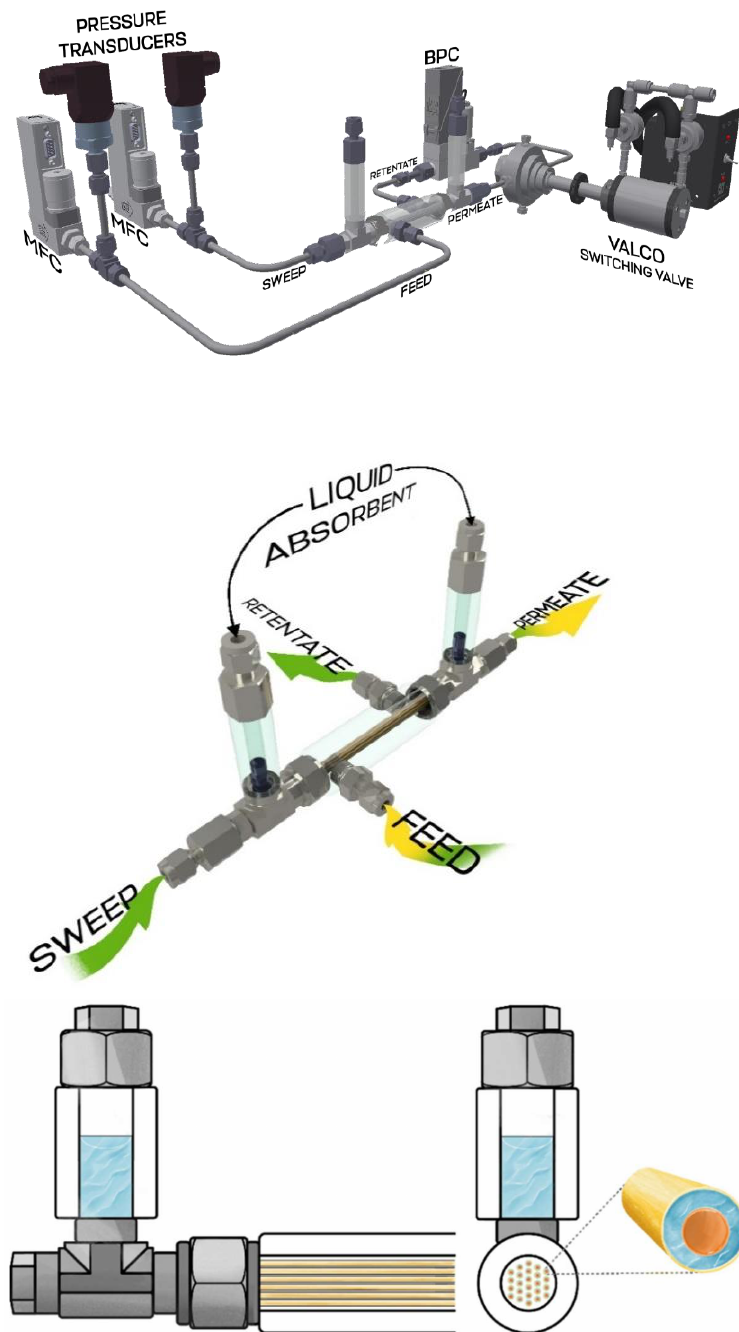
Figure 1. The 3D scheme of experimental setup for membrane-assisted gas absorption cell separation performance test (on the top), 3D image of the membrane-assisted gas separation cell (in the middle), and its principal scheme